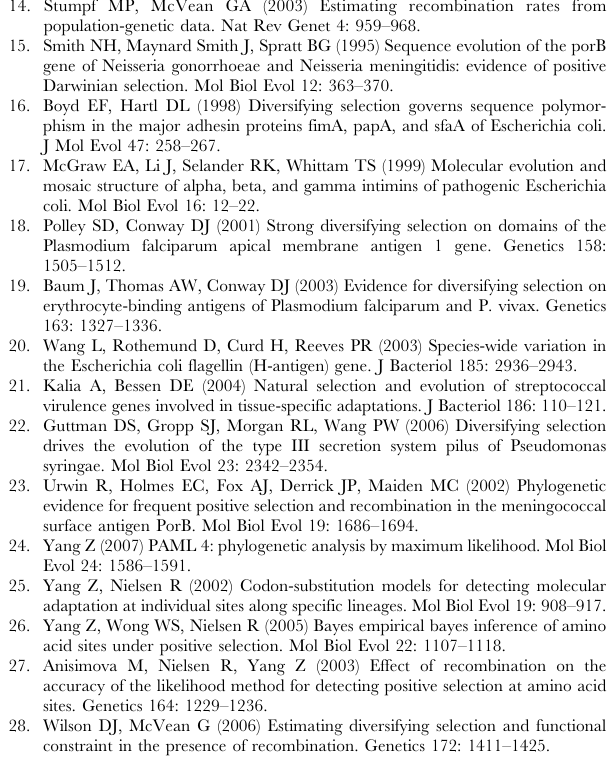
Table S2 Details of the recombination events detected in the sequence dataset using the RDP program